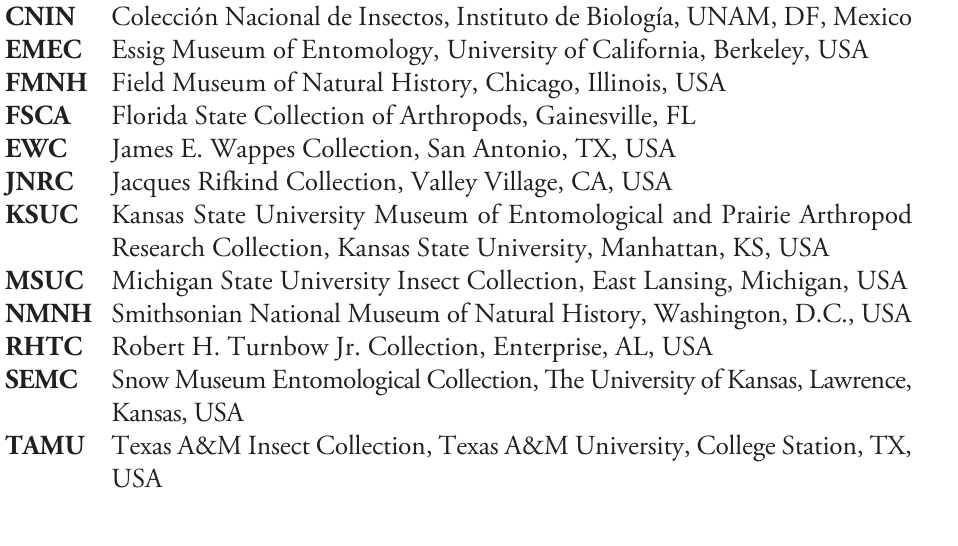
Key to species of Callotillus and Neocallotillus 1 Antennomeres 4-9 of males pectinate (Fig. 3A–C), antennomeres 4-9 of fe- males robust, serrate, (Fig. 3D–F); terminal maxillary palpomeres conical; slender to moderately robust species (Figs 1A–F, 4A) ....... Neocallotillus (2) – Antennomeres 4-9 of males strongly serrate (Fig. 3G–H), antennomeres 4-9 of females moderately serrate (Fig. 3I–J); terminal segments of maxillary palps cylindrical; robust species (Figs 1G–H, 4B) ................... Callotillus (4) 2 Elytral disc finely punctate, punctations irregularly arranged; median region of each elytron adorned with a transverse, light testaceous to almost whitish, slightly protruding fascia, and one protruding macula on the anterior half of the elytral disc, this macula can be absent in some specimens (Fig. 1A–D) ... .................................................................................. Neocallotillus elegans – Elytral disc devoid of punctations; fasciae pattern not as above, elytral disc variously adorned, larger individuals ........................................................... 3 3 Each elytron with a testaceous, broad and procurved fascia that initiates at the elytral suture and extends from the median region of the elytral disc to the elytral apex, and small, narrow, moderately oblique marking at the median region of the elytral disc; last third of elytral disc with a semicircular macula (Fig. 1F) ...................................................................... Neocallotillus crusoe – Each elytron adorned with a pair of elaborate, pale fasciae, and one macula arranged as follows: macula located on the anterior fourth, posterior to the humeral angle; one fascia located on anterior half of elytral disc, and strongly procurved, initiating on elytral suture and ending just before epipleural